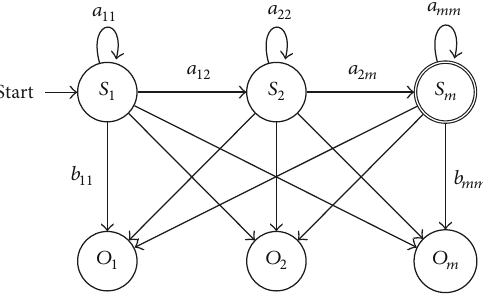
Figure 3: Emitted and observable states in HMM.